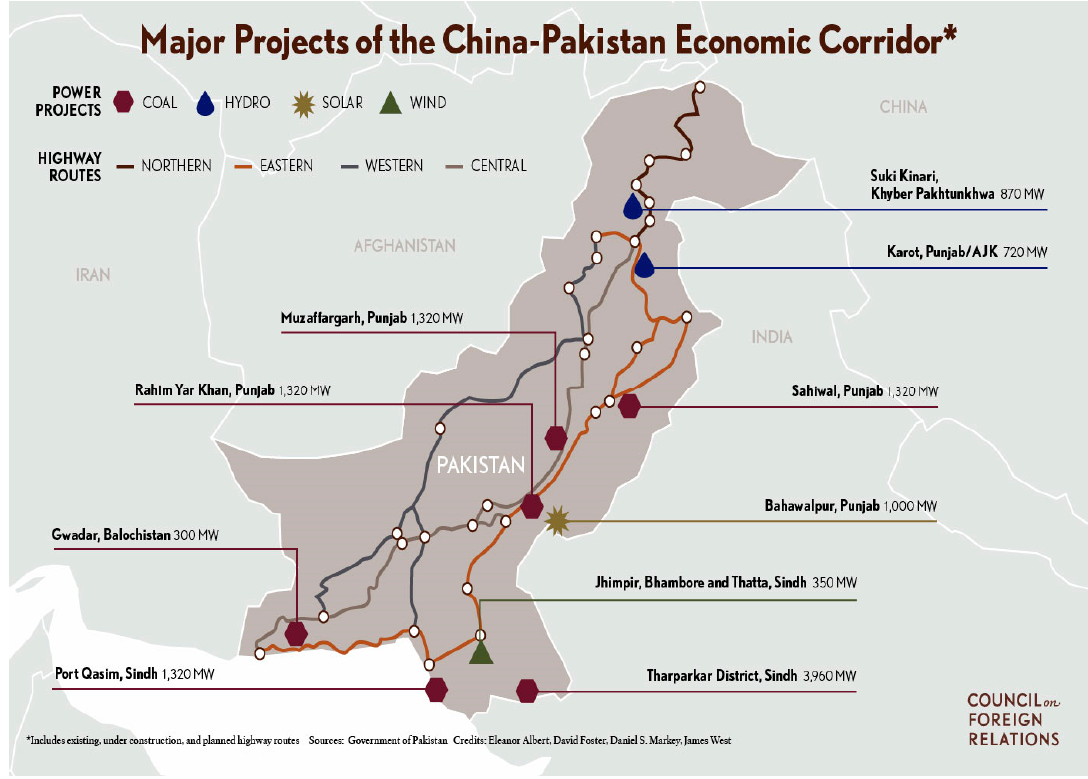
Figure 2. Energy projects under the China Pakistan Economic Corridor (CPEC) [21] .